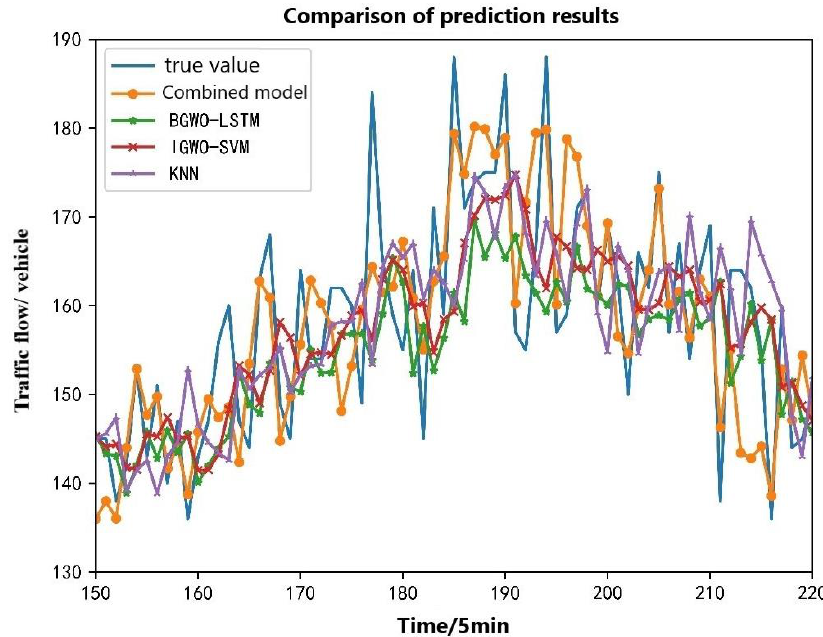
Figure 13. Comparison of local prediction results of different models.